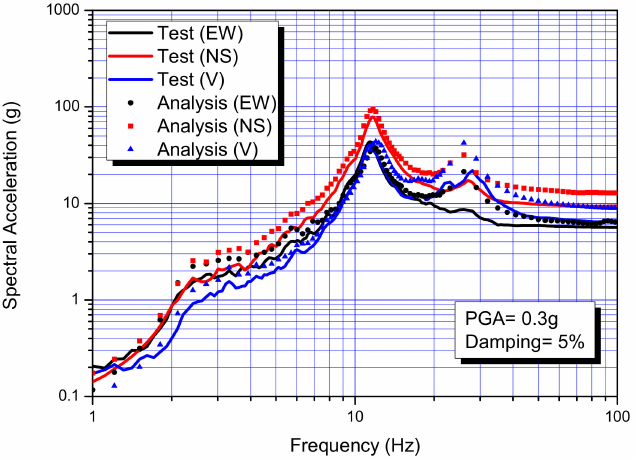
Figure 23. Comparison results of the response spectrum at the pipe end (Acceleromter-3) for PGA = 0.3